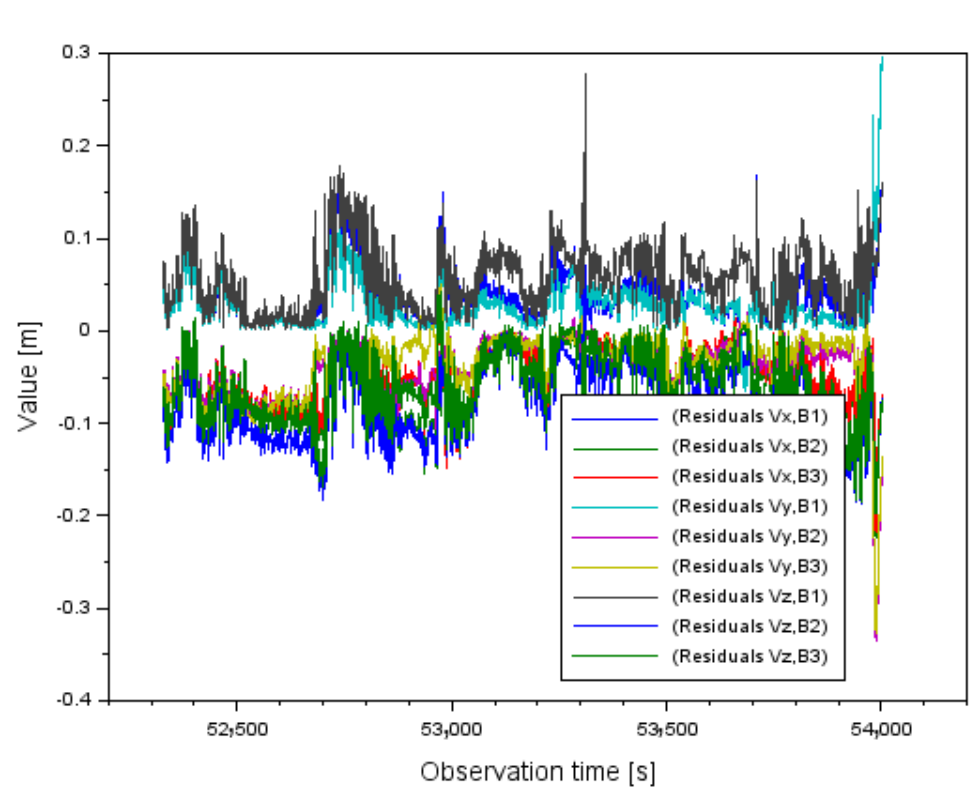
Figure 8. The residuals distribution for case I for measurement weight P = 1